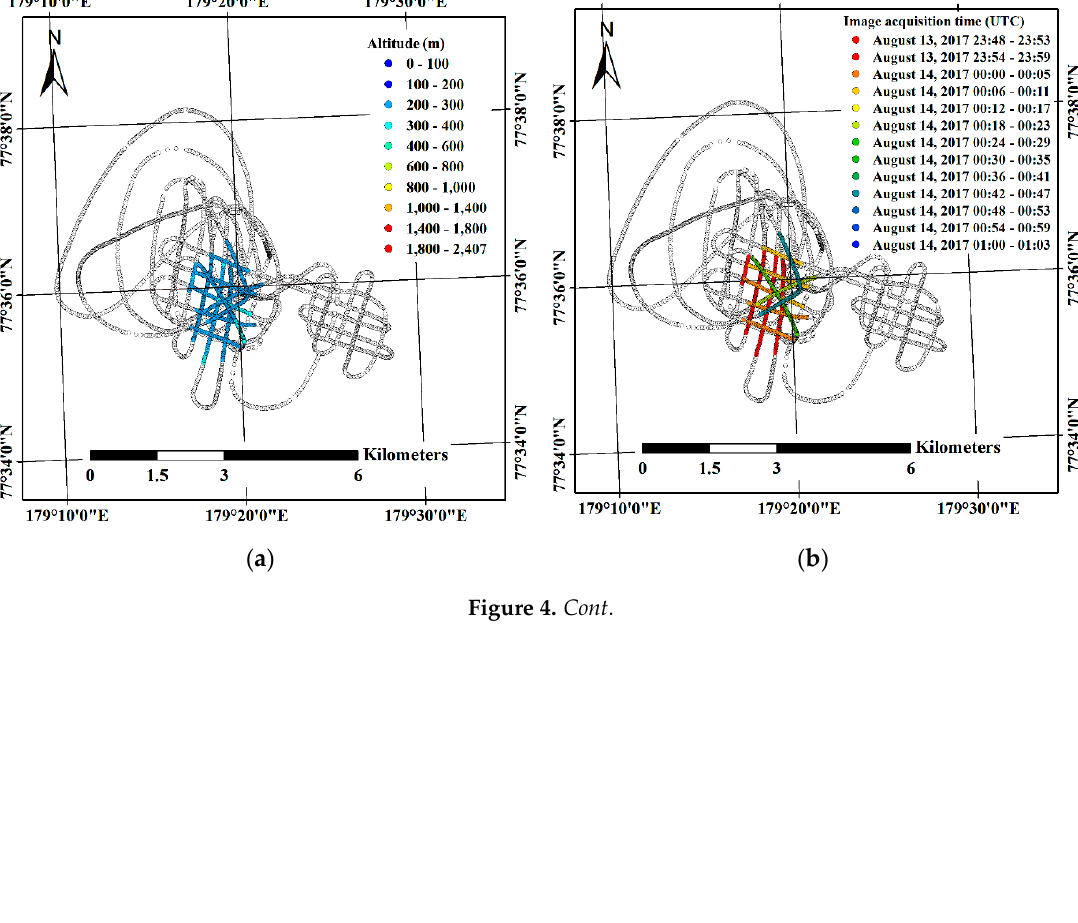
Figure 3. Helicopter-borne VHR image acquisition results: ( a ) locations and altitudes of image acquisition; and ( b ) corresponding image acquisition date and time, expressed as hh:mm. Table 4. Details for image subsets selected from helicopter-borne VHR images.